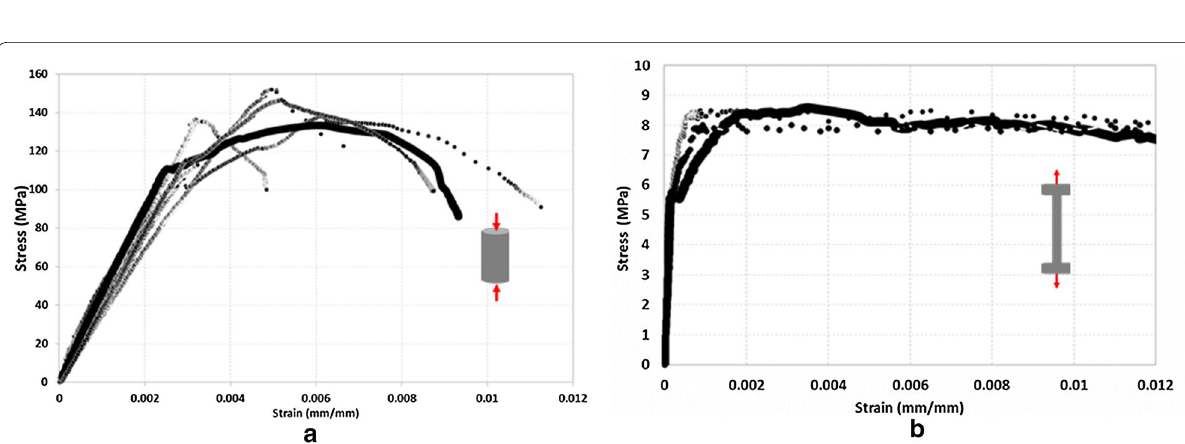
Fig. 3 Typical stress–strain behavior of UHPC, a in compression b in tension.